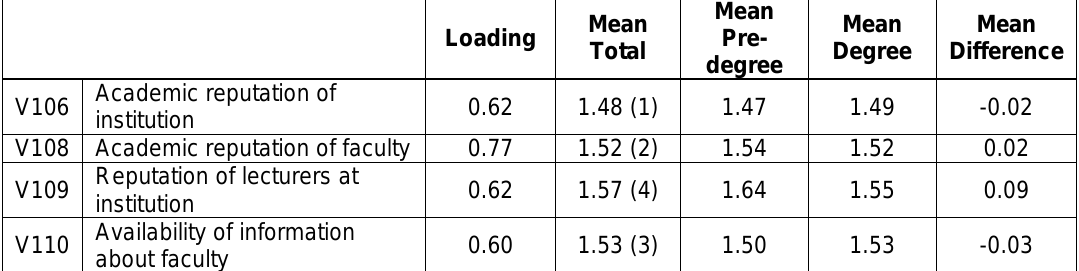
Table 3: Reputation of institution